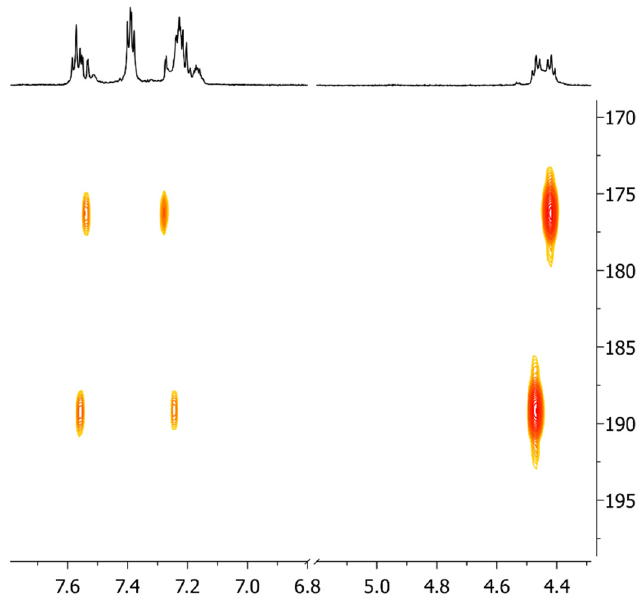
Figure 3. Detail of the 1 H, 13 C-HMBC-NMR spectrum of complex 8 in CD 3 CN: cross-peaks involving the carbene carbons.